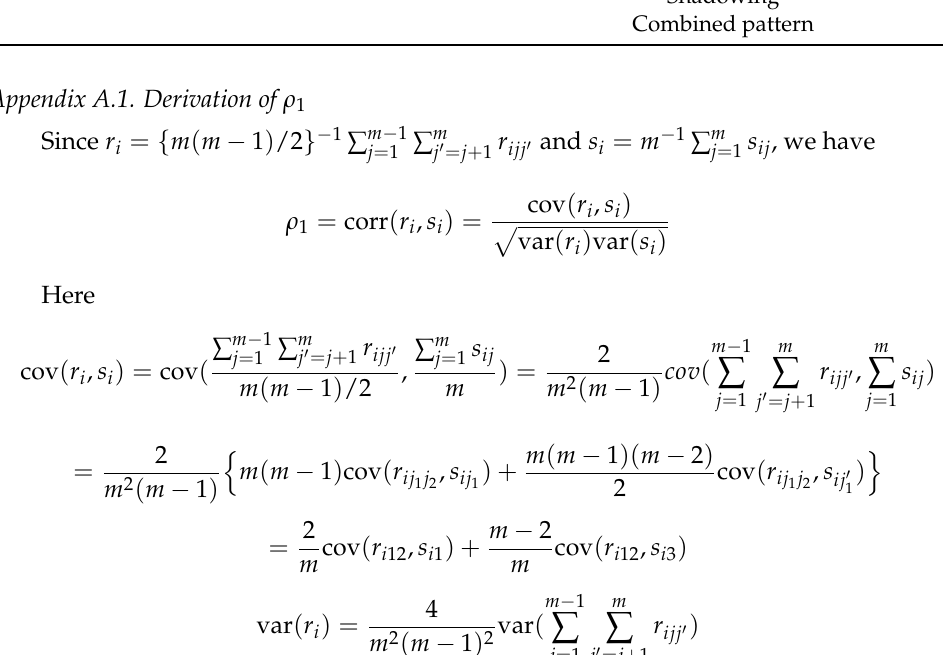
Round Irregular Indistinct Angular Microlobulated Spiculated Not parallel Hypoechoic Complex cystic and solid Isoechoic Hyperechoic Heterogeneous Enhancement Shadowing Combined